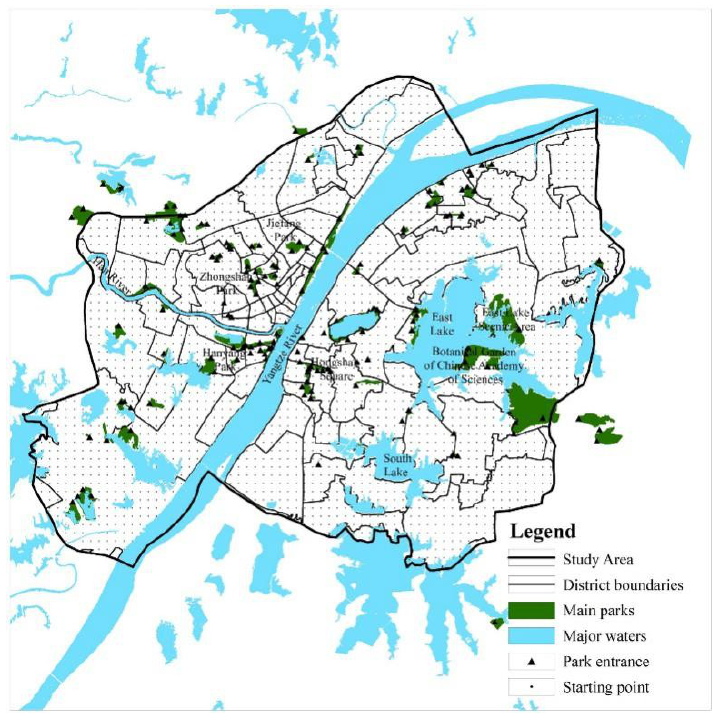
Figure 2. The distribution of main parks in Wuhan.